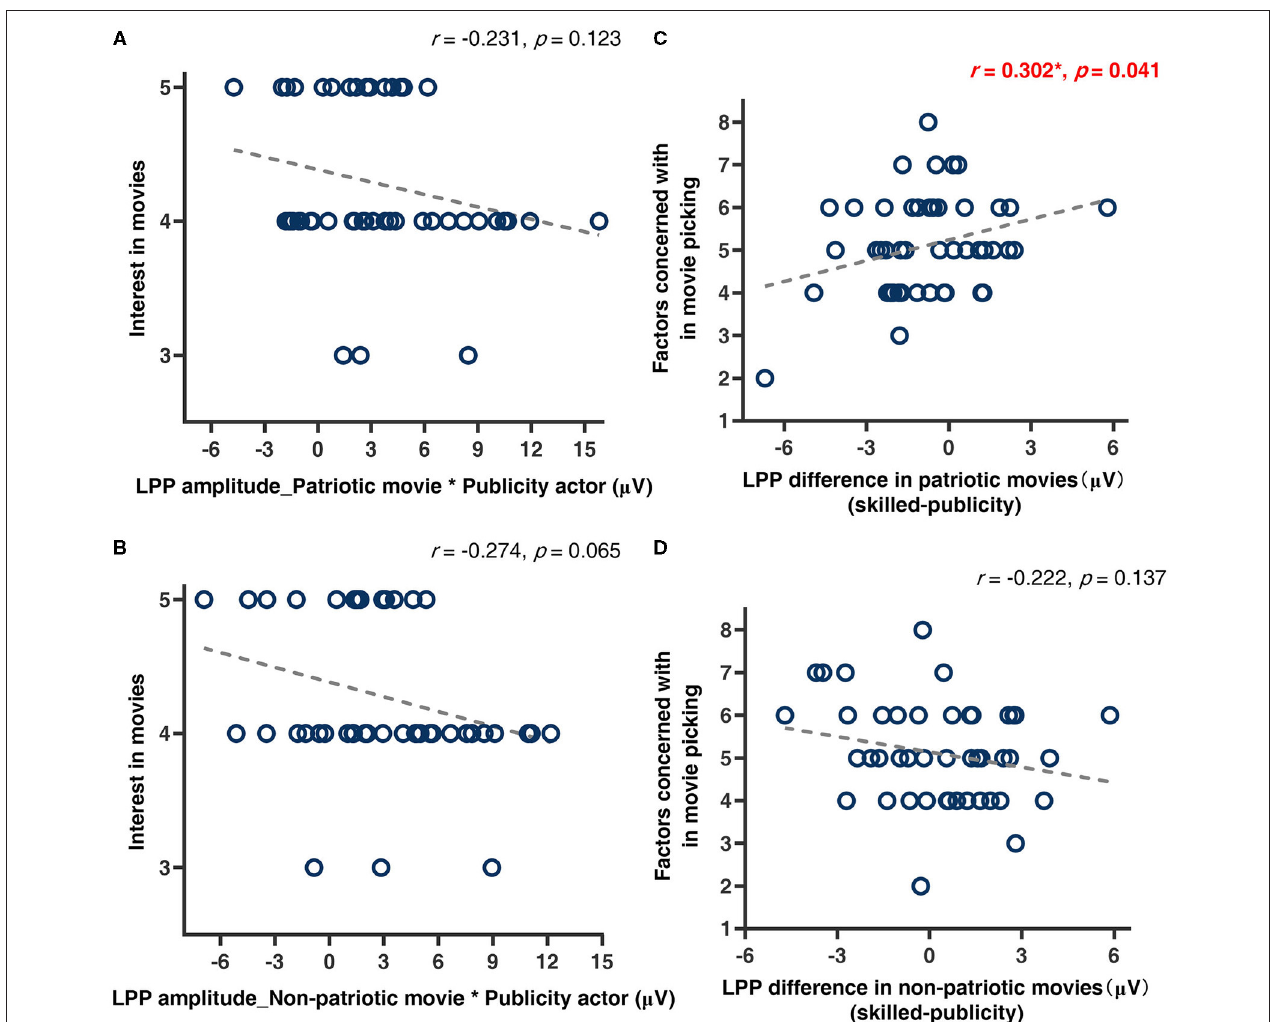
FIGURE 5 | Scatter plots and Pearson’s correlation coefficient analysis results. (A,B) Correlations between average LPP amplitude and the degree of interest in movies under publicity actor conditions. (C,D) Correlations between LPP amplitude difference (skilled–publicity) in different movie types and the number of factors each participant concerned with in movie